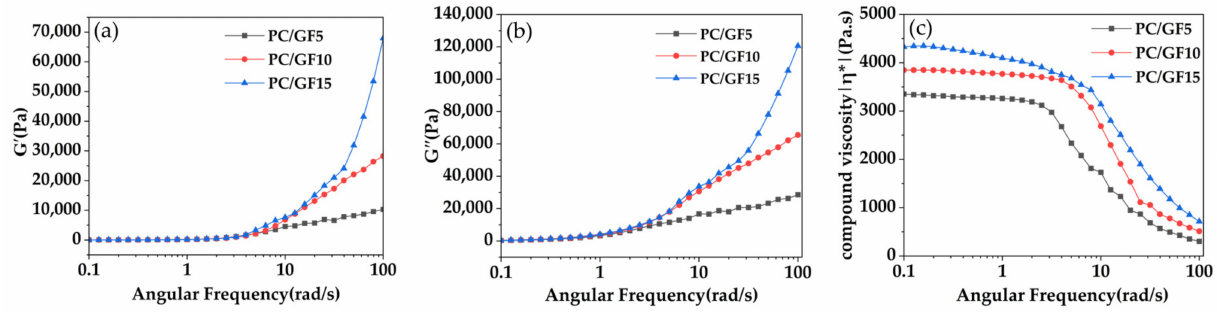
Figure 2. Energy storage modulus G (cid:48) ( a ), loss modulus G” ( b ) and composite viscosity η * ( c ) of PC/GF composites versus